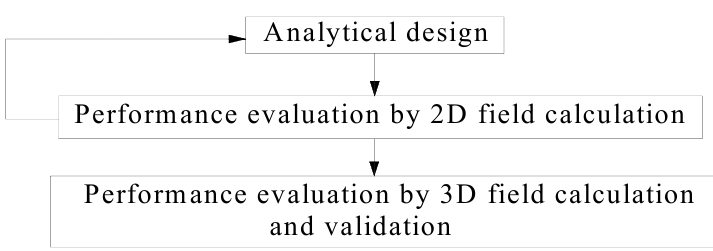
Figure 17. Flowchart of the design